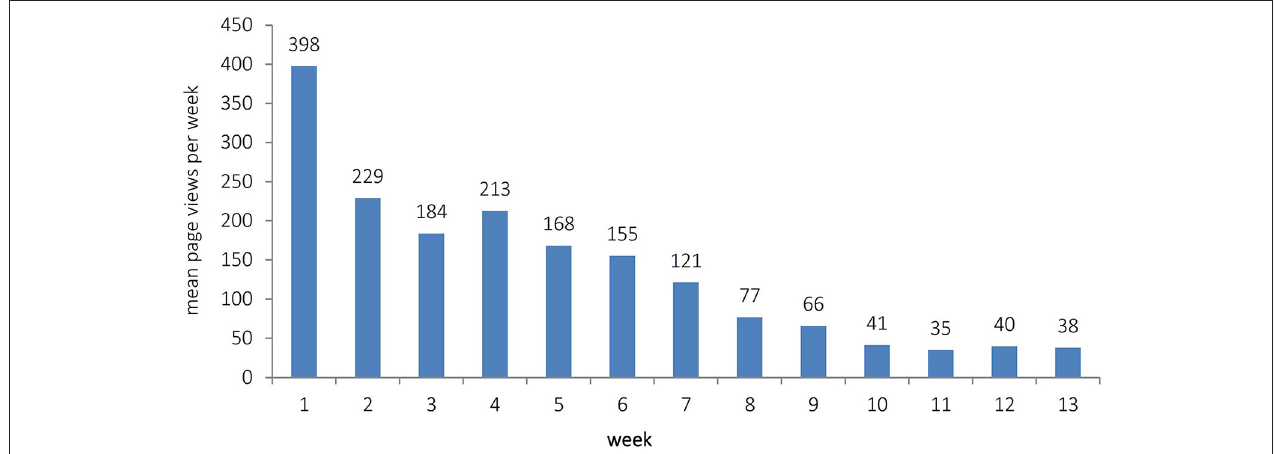
FIGURE 1 | Mean page views for all 13 weeks, in which the blog was online.